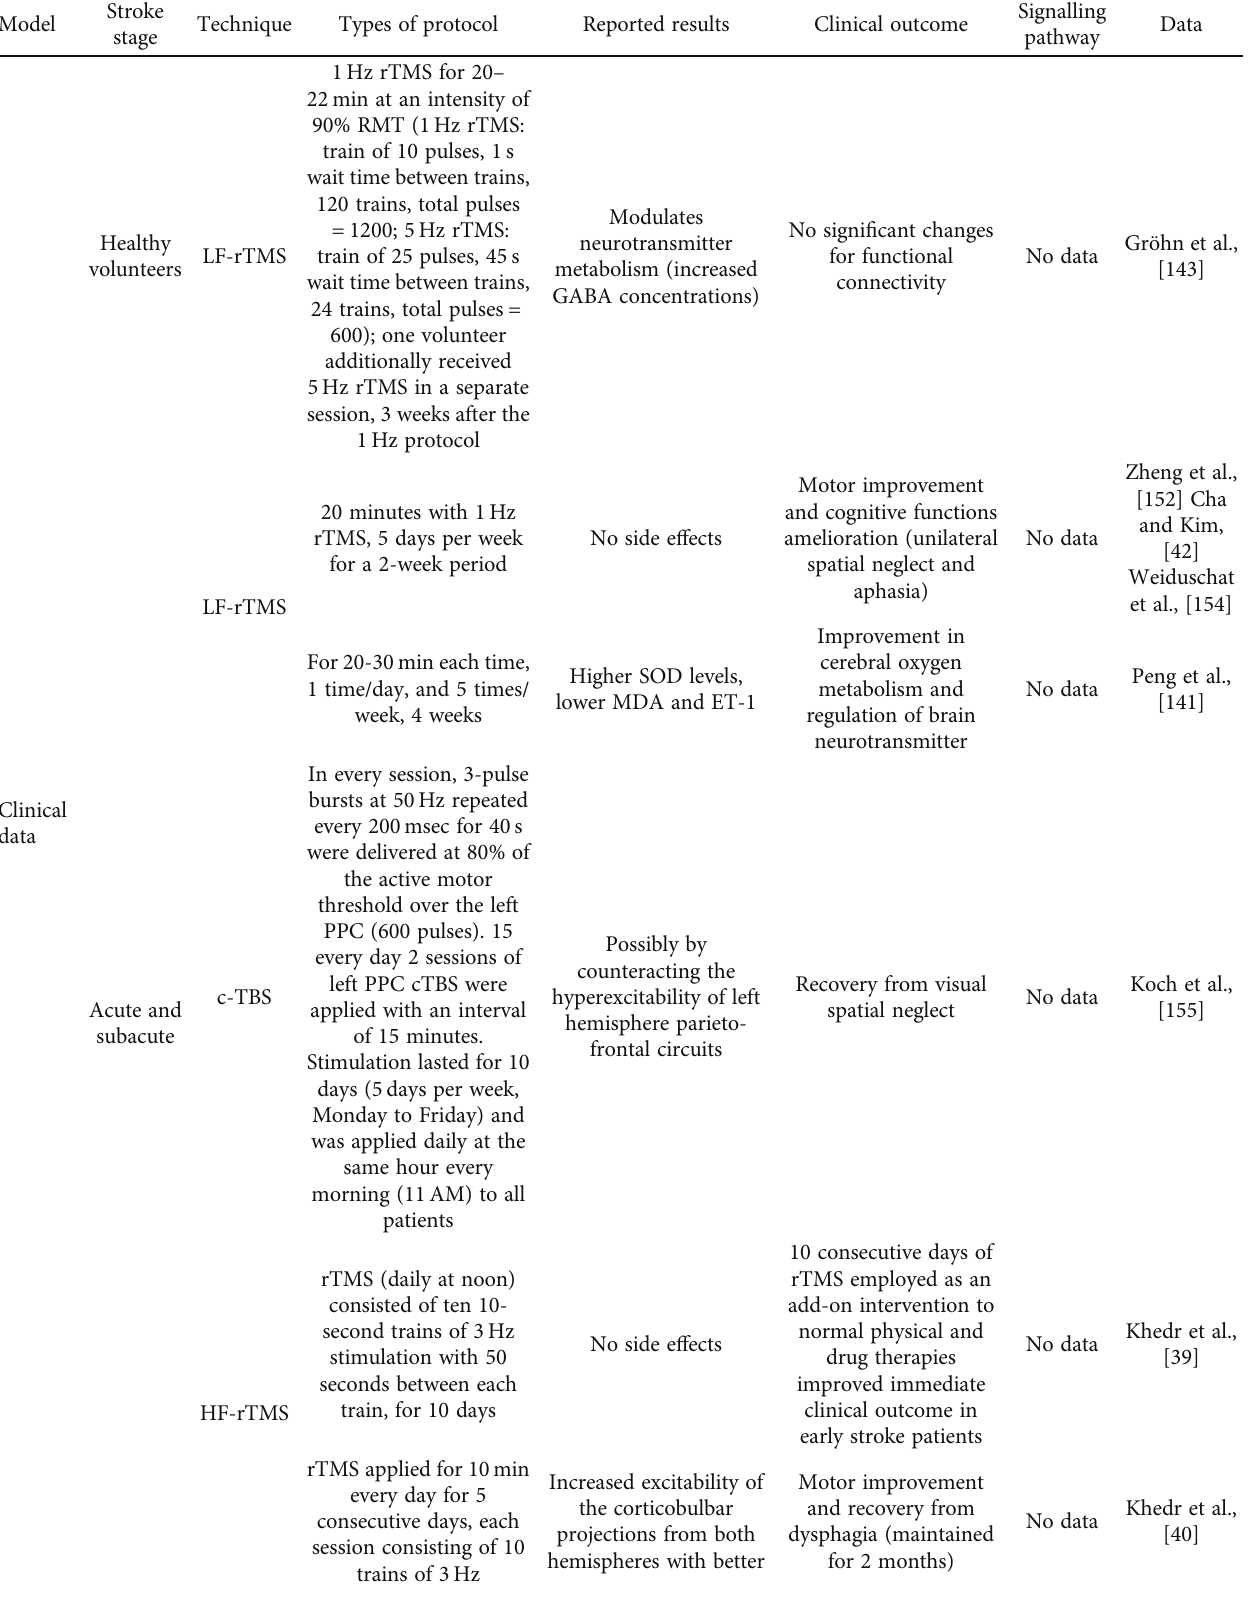
Table 4: Main clinical outcomes after transcranial magnetic